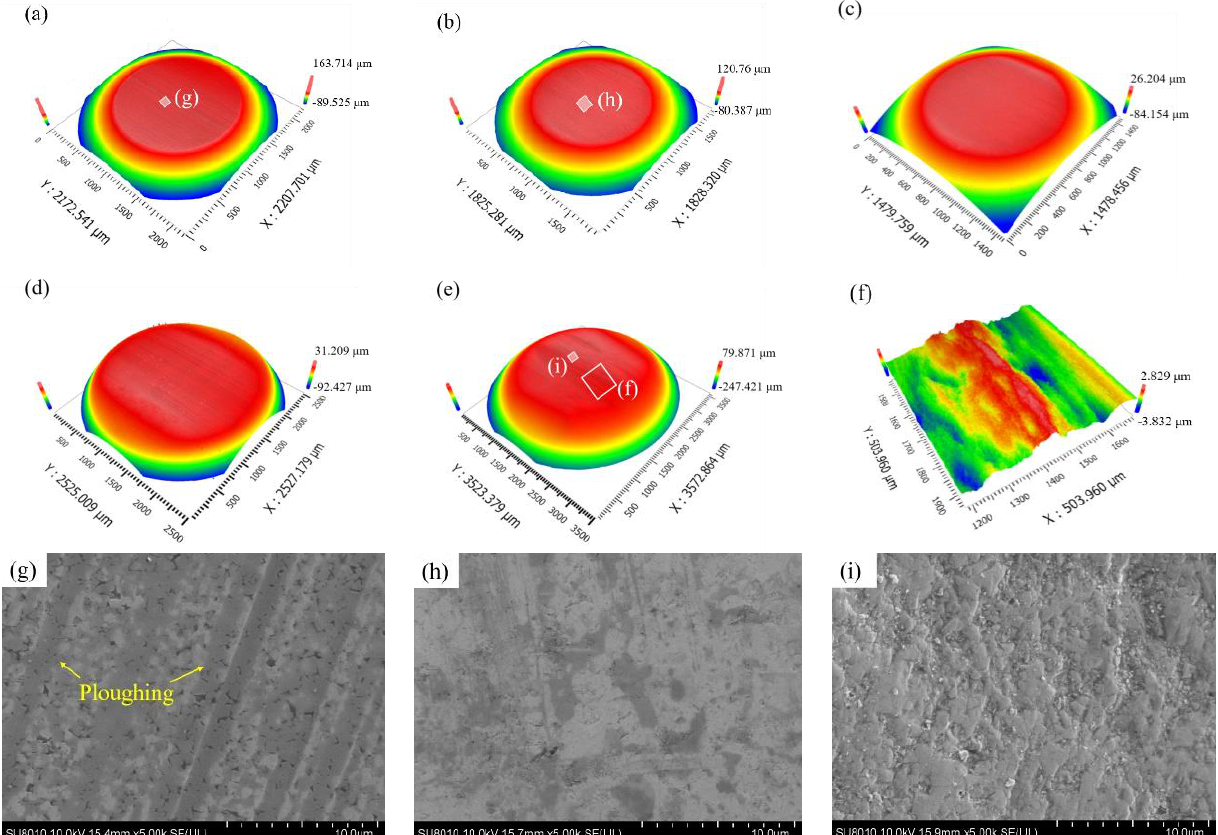
Figure 7. Wear scar morphology of WC ball under different particle size conditions: Three − dimen- sional morphology ( a , g ) no particles; ( b , h ) 1.5 μm; ( c ) 4 μm; ( d ) 12 μm; ( e , i ) 36 μm; ( f ) the micro − re- gion of ( e ).